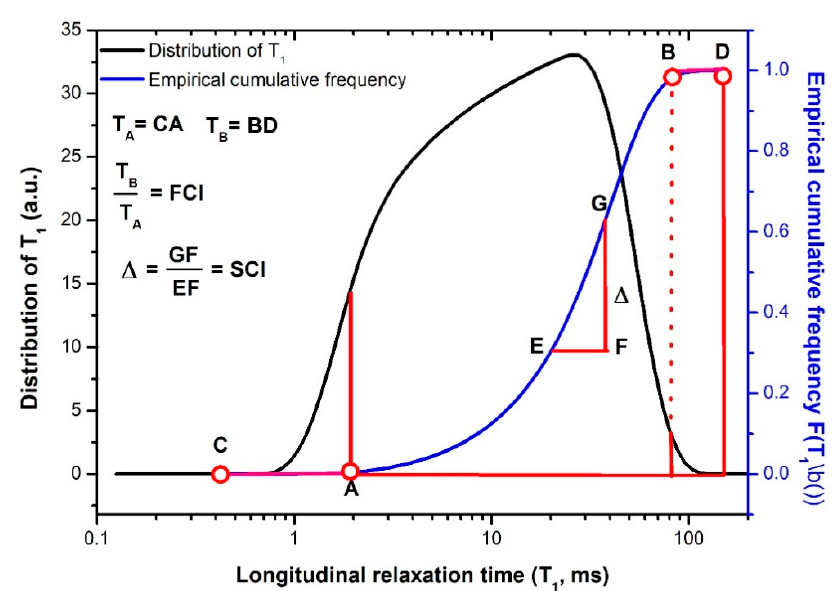
Figure 14. The black curve is the relaxogram acquired at the proton Larmor frequency of 30 MHz for one of the soils described in Reference [89]. This relaxogram has never been published, and is only discussed in the aforementioned reference. The blue curve is the empirical cumulative frequency obtained by the integration of the relaxogram. The segments CA, having length T A (expressed in ms), and BD, with the length T B (in ms), represent the amount of fast- and slow-relaxing nuclei, respectively, corresponding both to 1% of the empirical cumulative frequency curve. The ratio T B / T A is the functional connectivity index (FCI). The slope ∆ = GF / EF is the structural connectivity index (SCI).